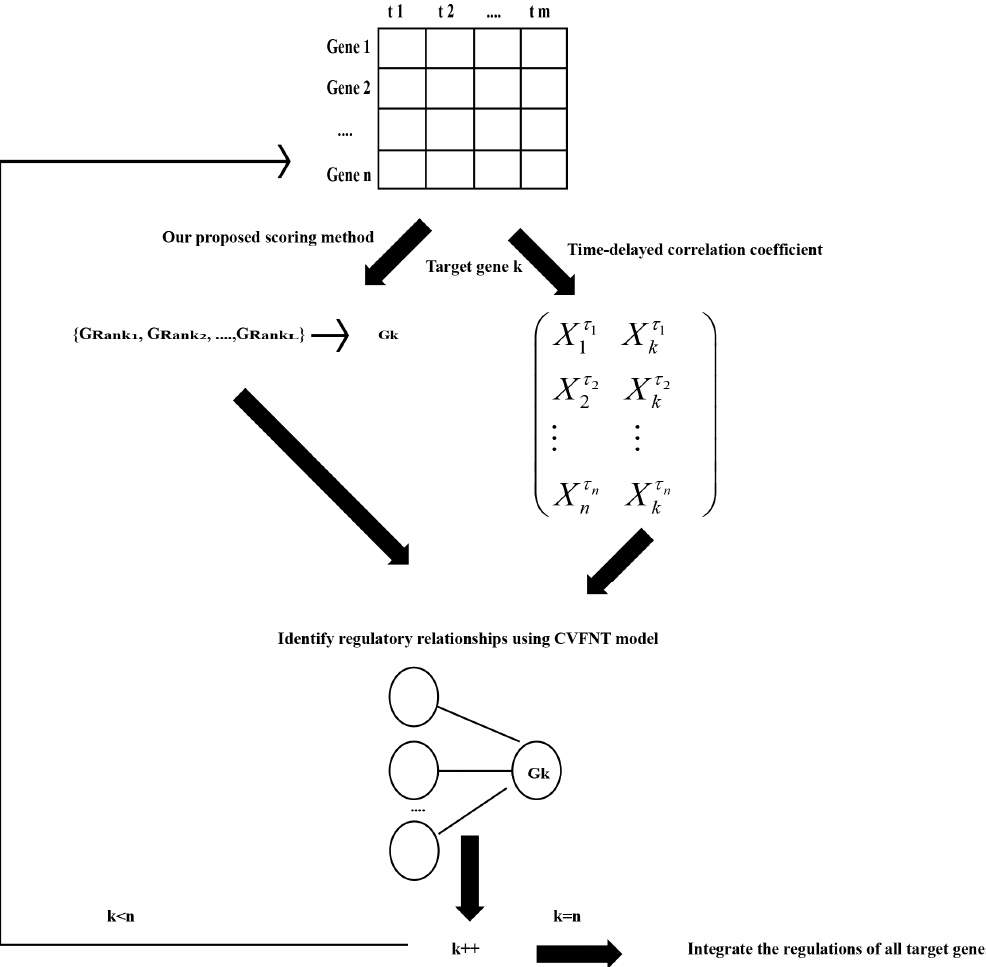
Figure 18. The flowchart of an HSCVFNT algorithm.